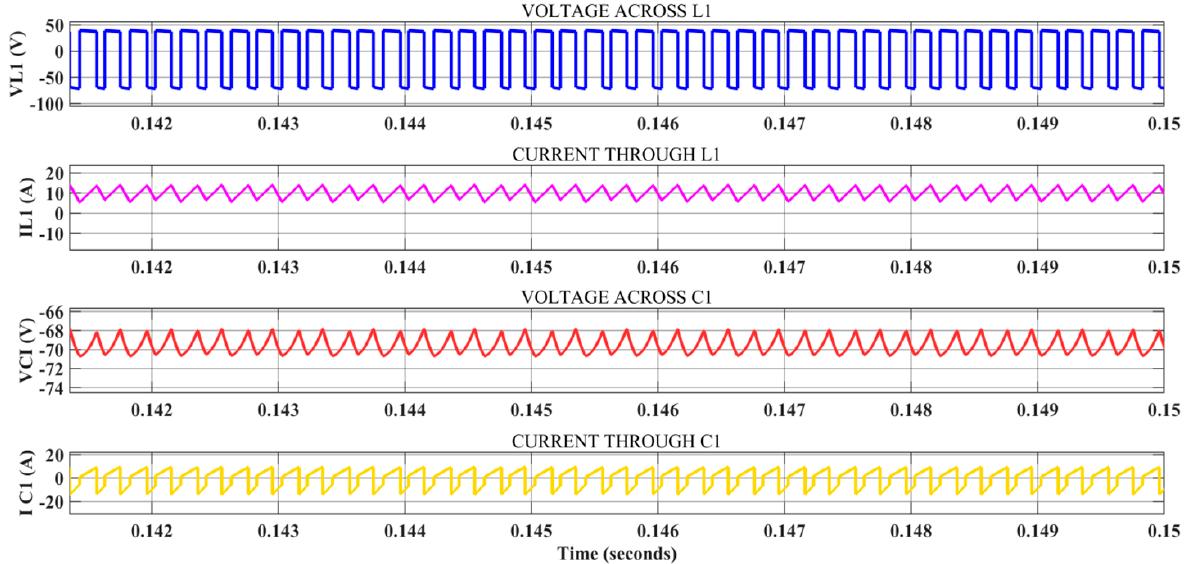
Figure 11. Waveforms of voltage across L 1 , C 1 and current through L 1 , and C 1 .